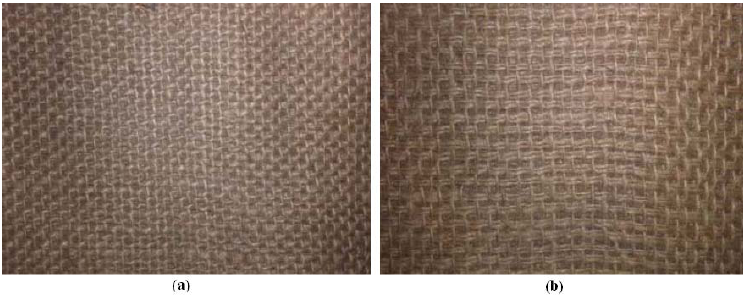
Figure 2. Hemp fabric: ( a ) type “A”; ( b ) type “B”.